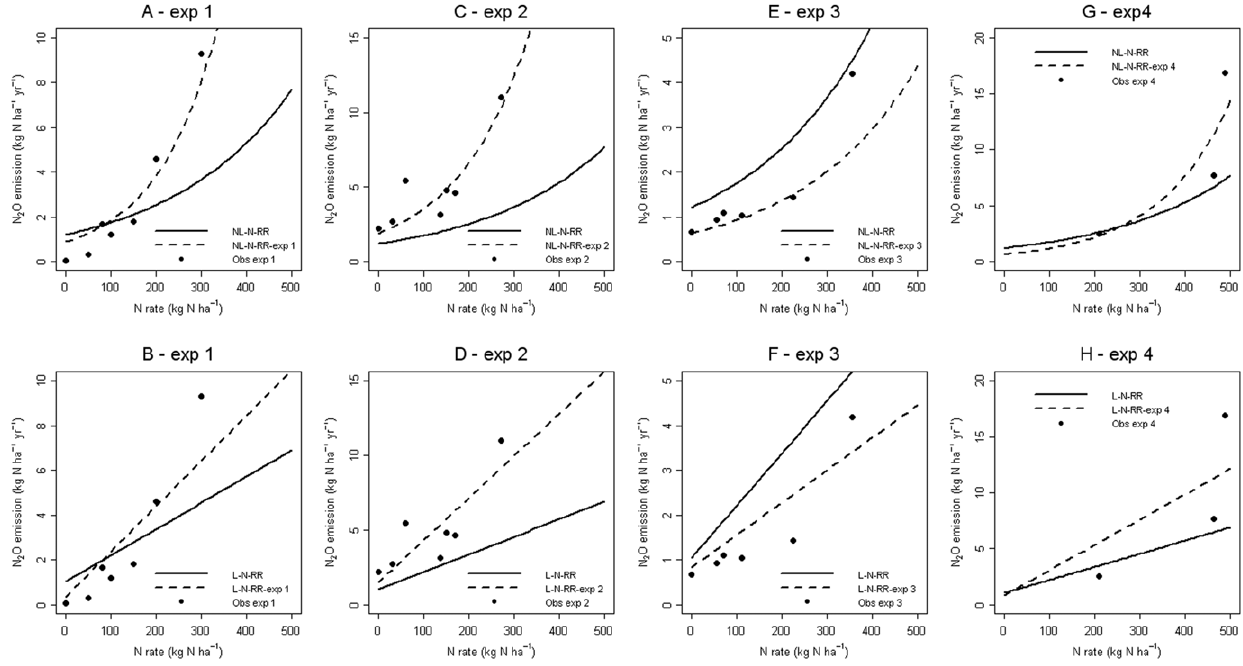
Figure 2. Fitted response curves for four experiments (exp 1: (A–B), exp 2: (C–D), exp 3: (E–F) and exp 4: (G–H)). For each published- experiment, mean response (solid black line) and experiment-specific response (dotted black line) were calculated with model NL-N-RR (A, C, E, G) and model L-N-RR (B, D, F, H). Black points represent N 2 O data averaged over replicates.